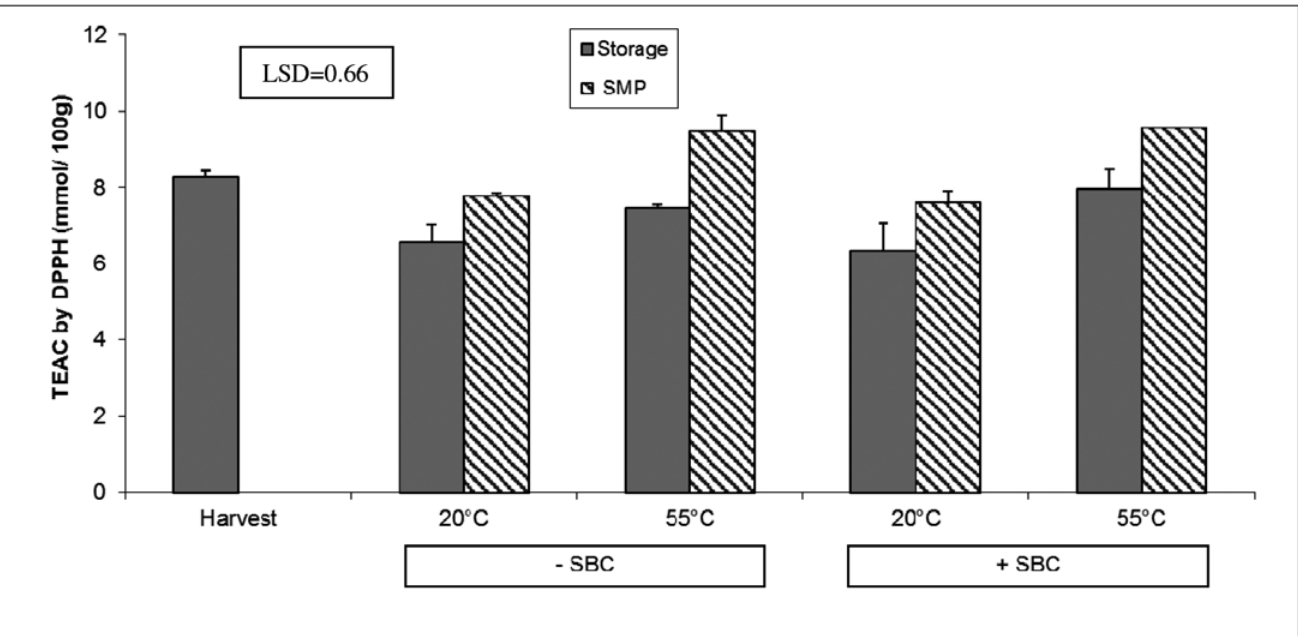
Fig. 2 - Total antioxidant activity in ‘Meloni’ plum immersed for 60 s in water at 20 and 55°C, with (+) or without (-) BCS, expressed as TEAC units (mmol Trolox equivalents per 100 g of fruit) by DPPH assay, after 1 month of storage at 5°C and 95% RH and 6 days at 20°C and 80% RH